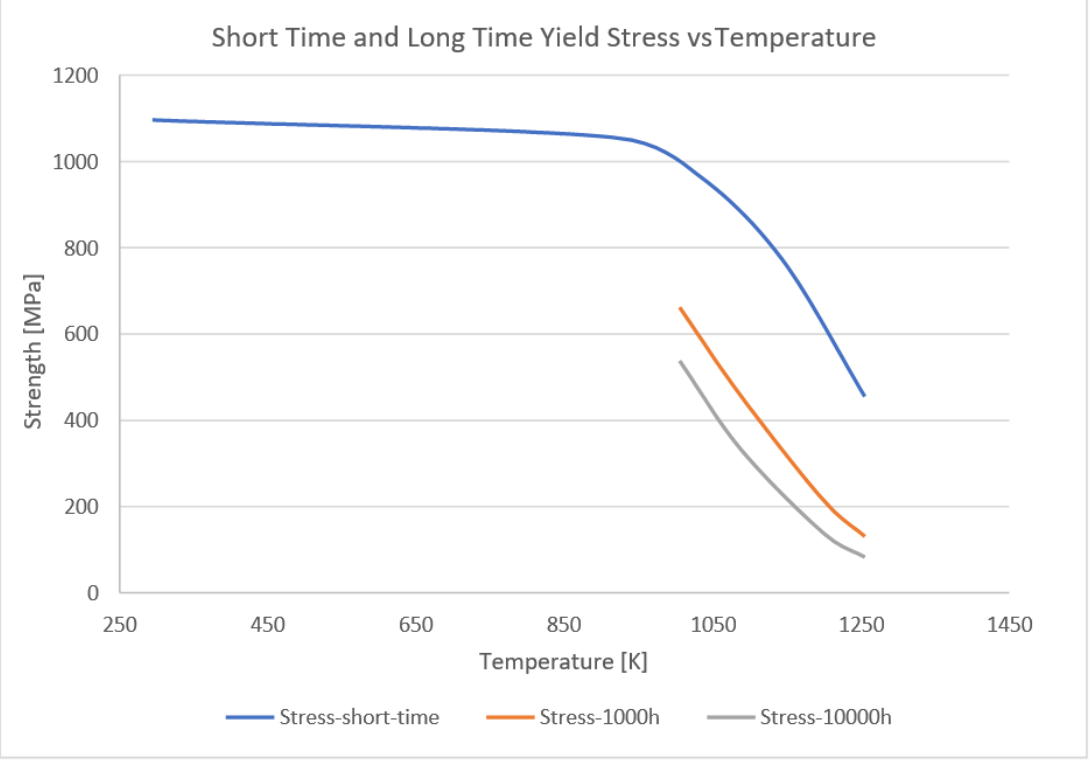
Figure 12. Inconel-738 performance plots calculated with data by Inco.